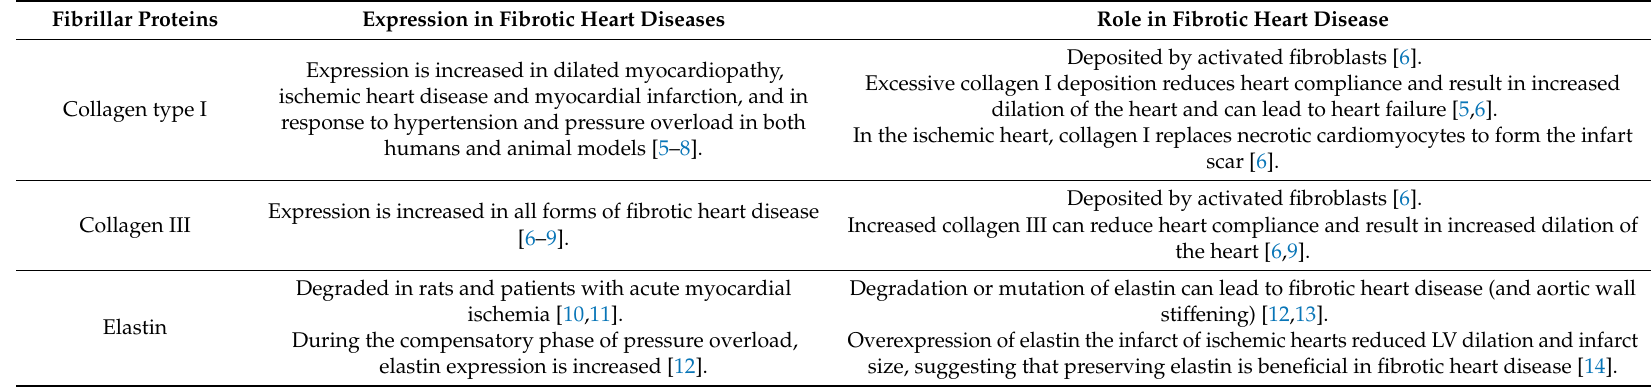
Table 1. Fibrillar extracellular matrix (ECM) proteins in the heart that contribute to myocardial fibrosis.